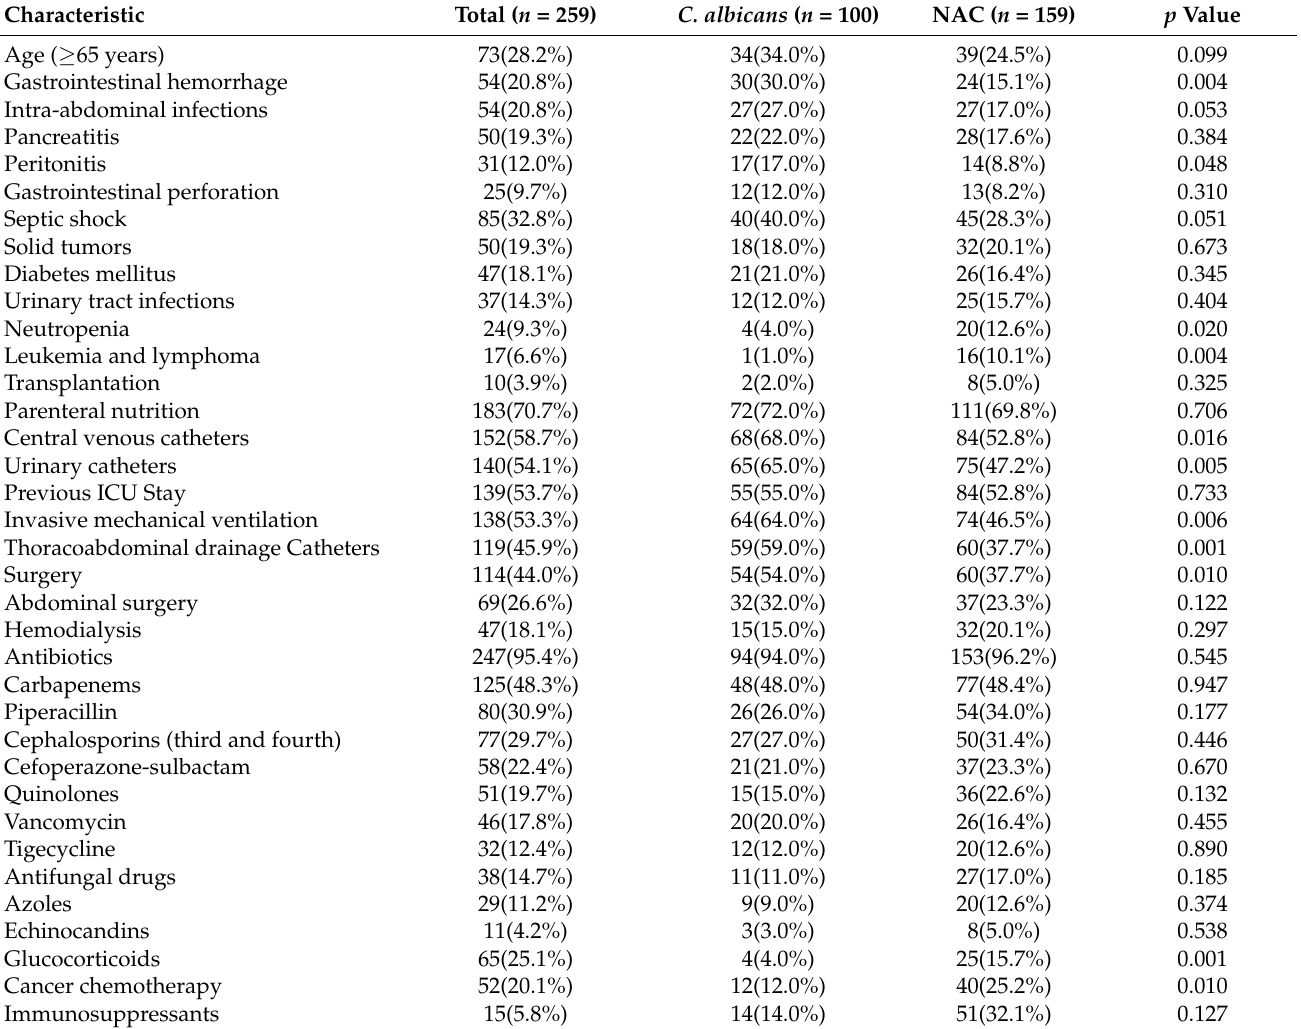
Table 4. Univariate analysis for risk factors regarding patients with C. albicans vs. NAC